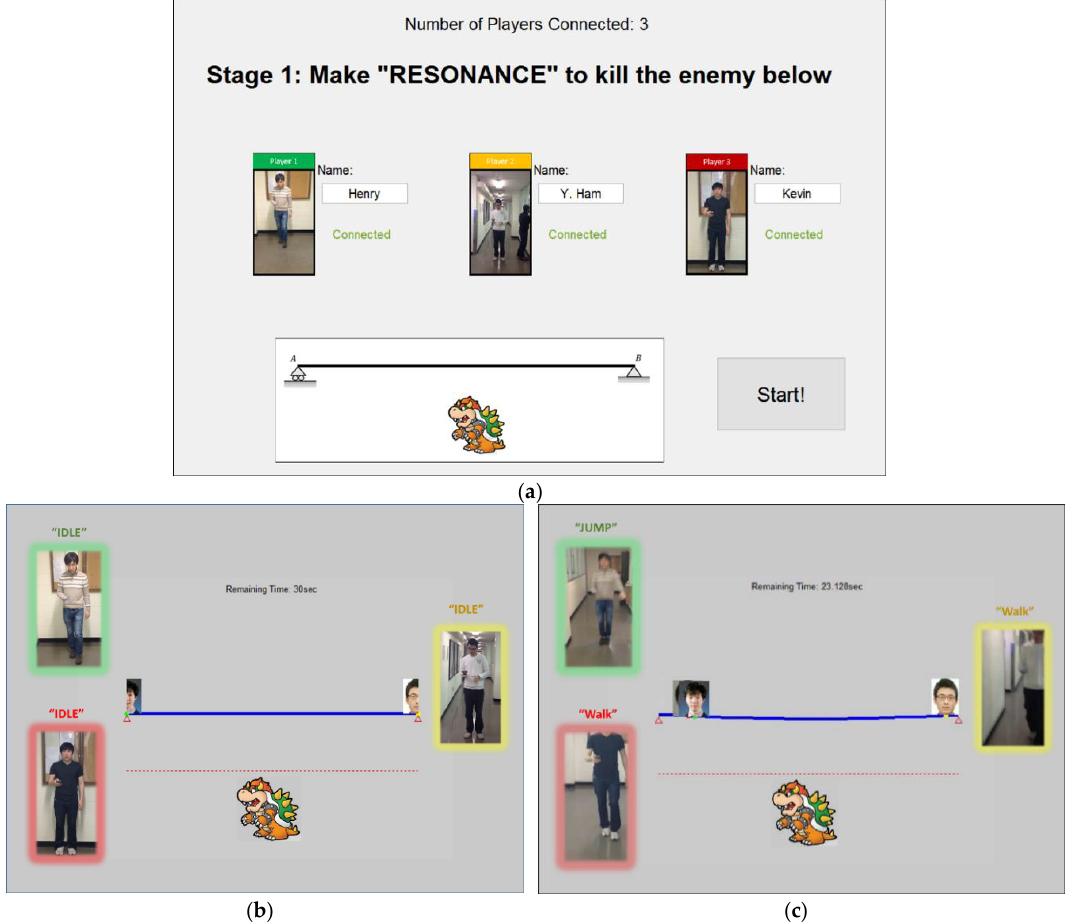
Figure 9. ( a ) Initial screen of the system for setup; ( b ) play screen at time = 0; ( c ) play screen with three moving users.